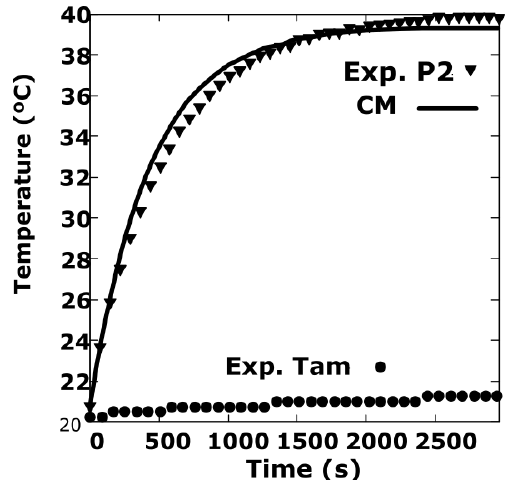
Figure 15. Verification of the simulation of the transient regime at point P2 versus the experimental data with the following values: CM [ h eff (Cu) = 8.4, h eff (Fe) = 30] W/m 2 K, d = 3 mm y w r = 15.7 rad/s. The ambient temperature and that of point P2 are measured with the MLX90614 temperature sensor.